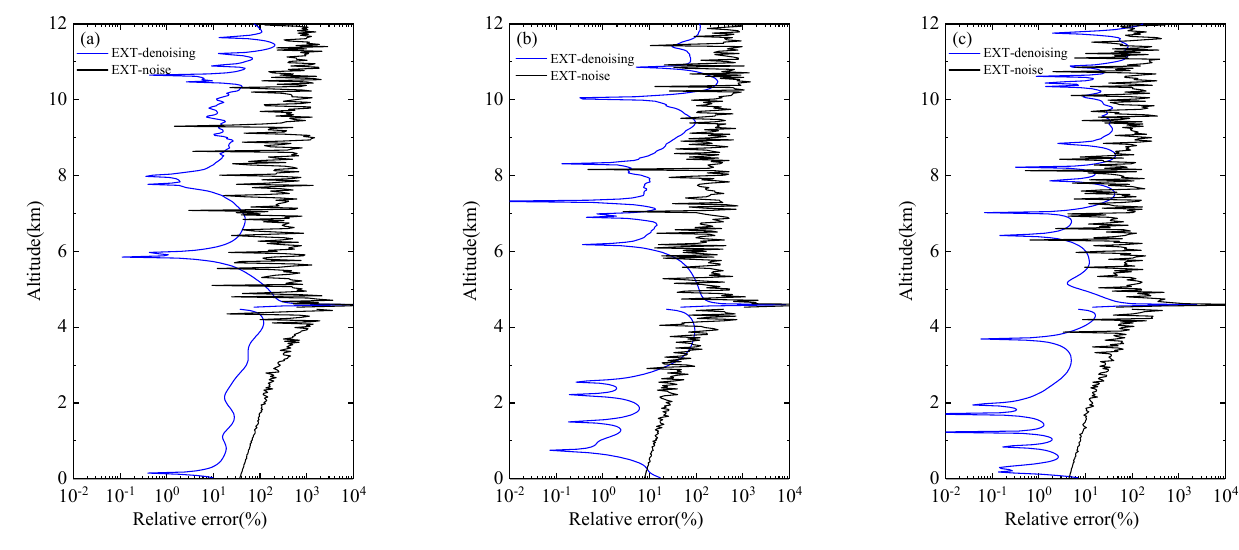
Figure 5. Comparison of relative error of extinction coefficient before and after denoising (no